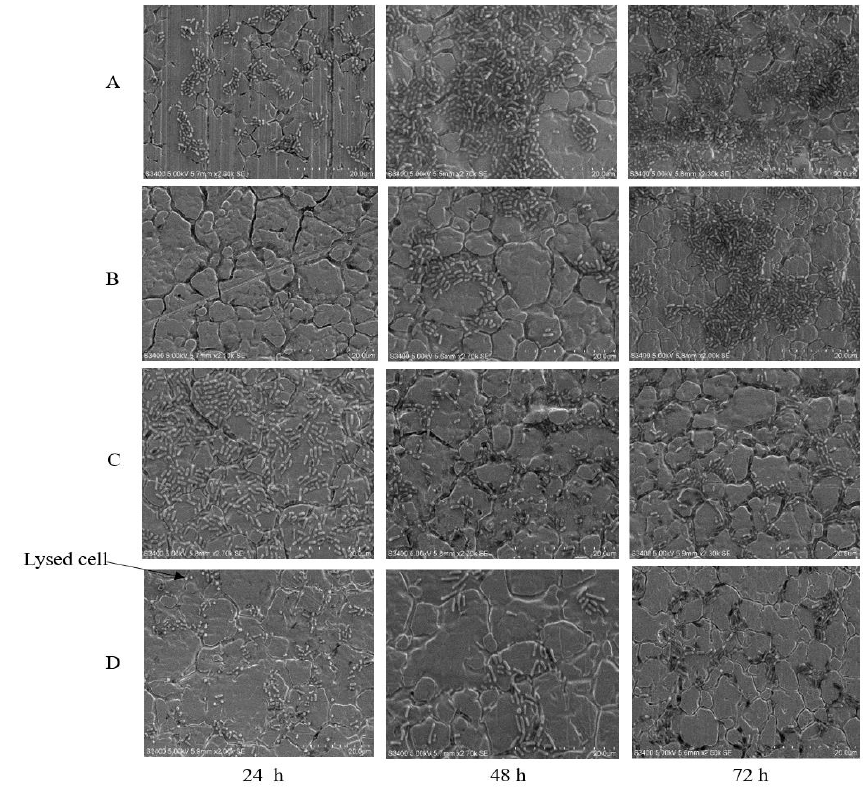
Figure 3. Scanning electron microscopy images for phage-treated (10 13 PFU/mL) biofilms after 24, 48 and 72 h of incubation. E . coli O154:H10 untreated controls ( A ) and phage-treated ( B ), and E . coli O113:H21 untreated controls ( C ) and phage-treated ( D ). Bar = 20 µm.